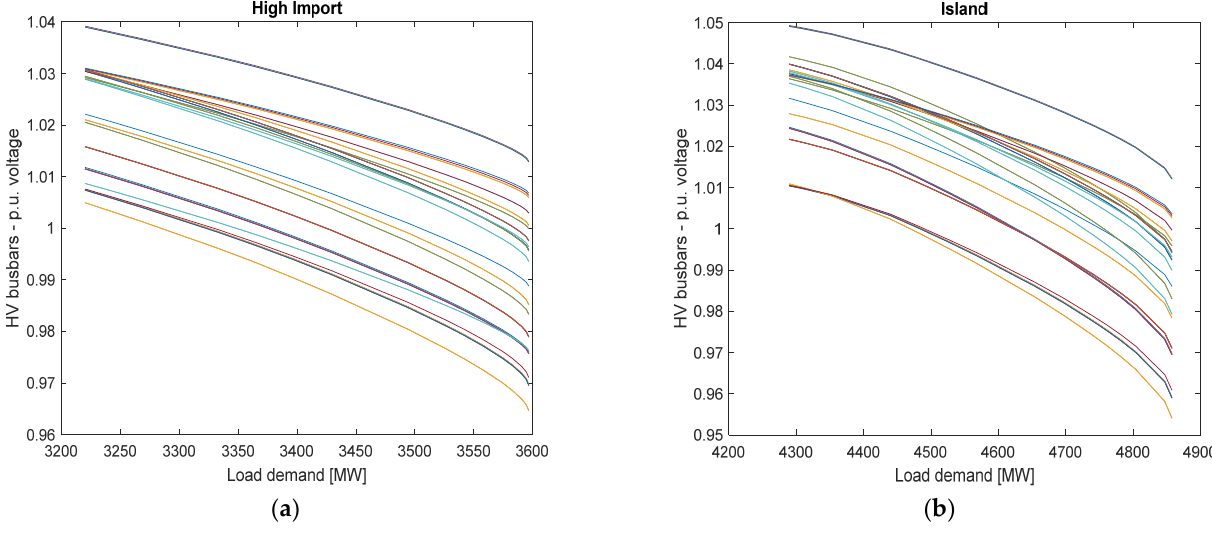
Figure 17. HV voltage profile of the High Import DP ( a ), HV voltage profile of the Island DP ( b ).